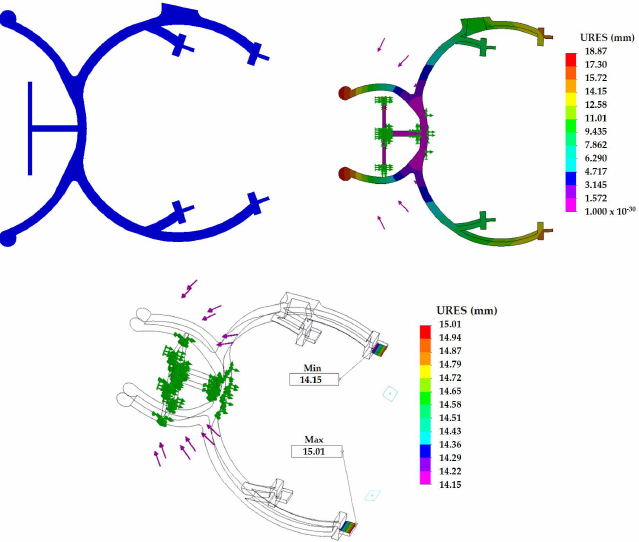
Figure 6. Obtained results for compliant mechanism with four gripping elements.